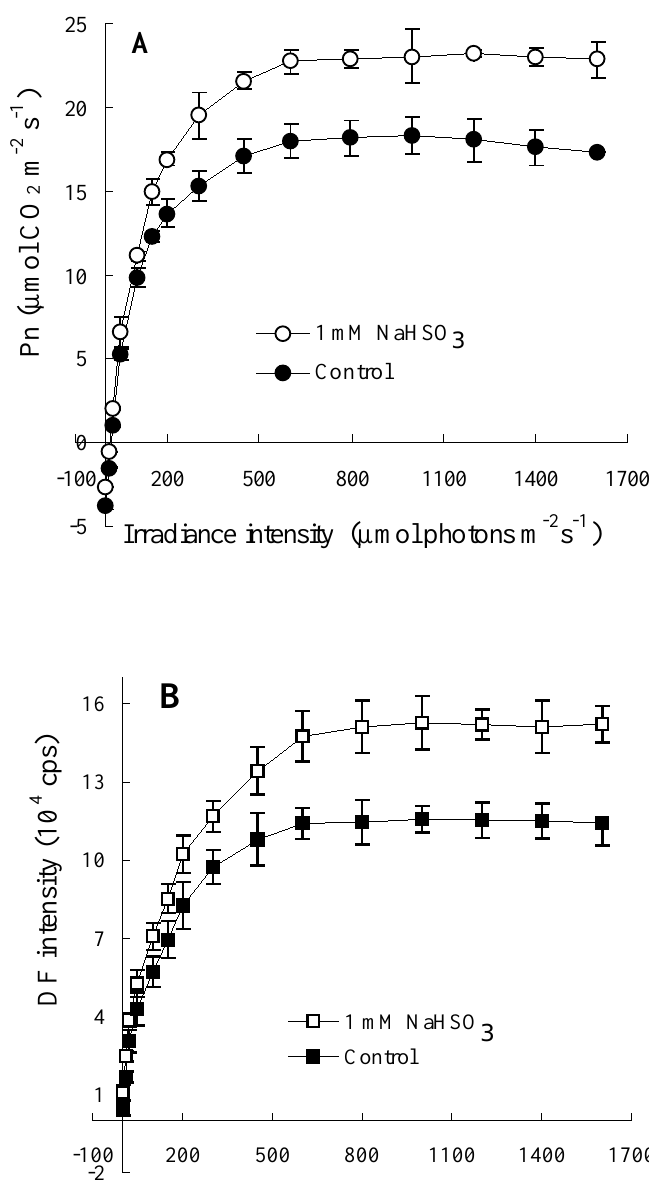
Figure 3. Light response curves of Pn (A) and DF intensity (B) of leaves of soybean ( Glycine max Zaoshu No. 18) seedlings exposed to 1mM NaHSO the mean ± S.E. of nine independent